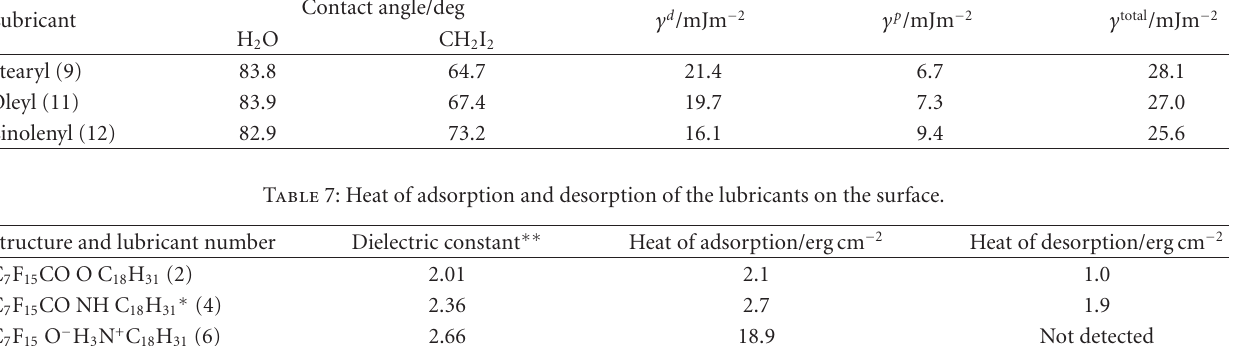
Table 6: Calculated dispersion and polar contribution to surface energy based upon contact angle measurements. Lubricant